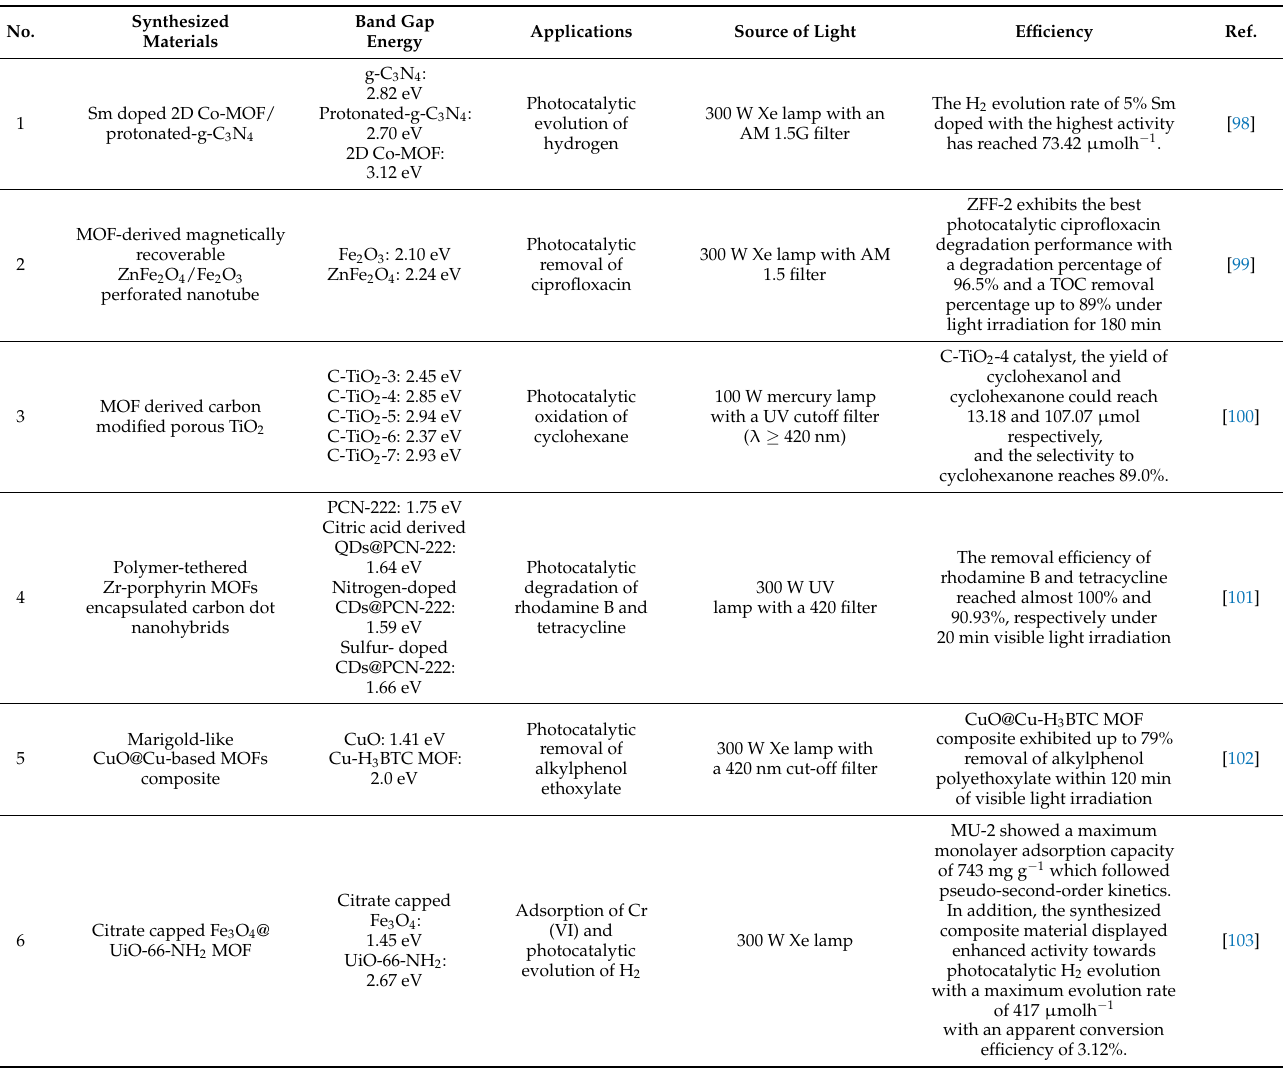
Table 3. Different photocatalytic applications of MOFs and MOFs-based